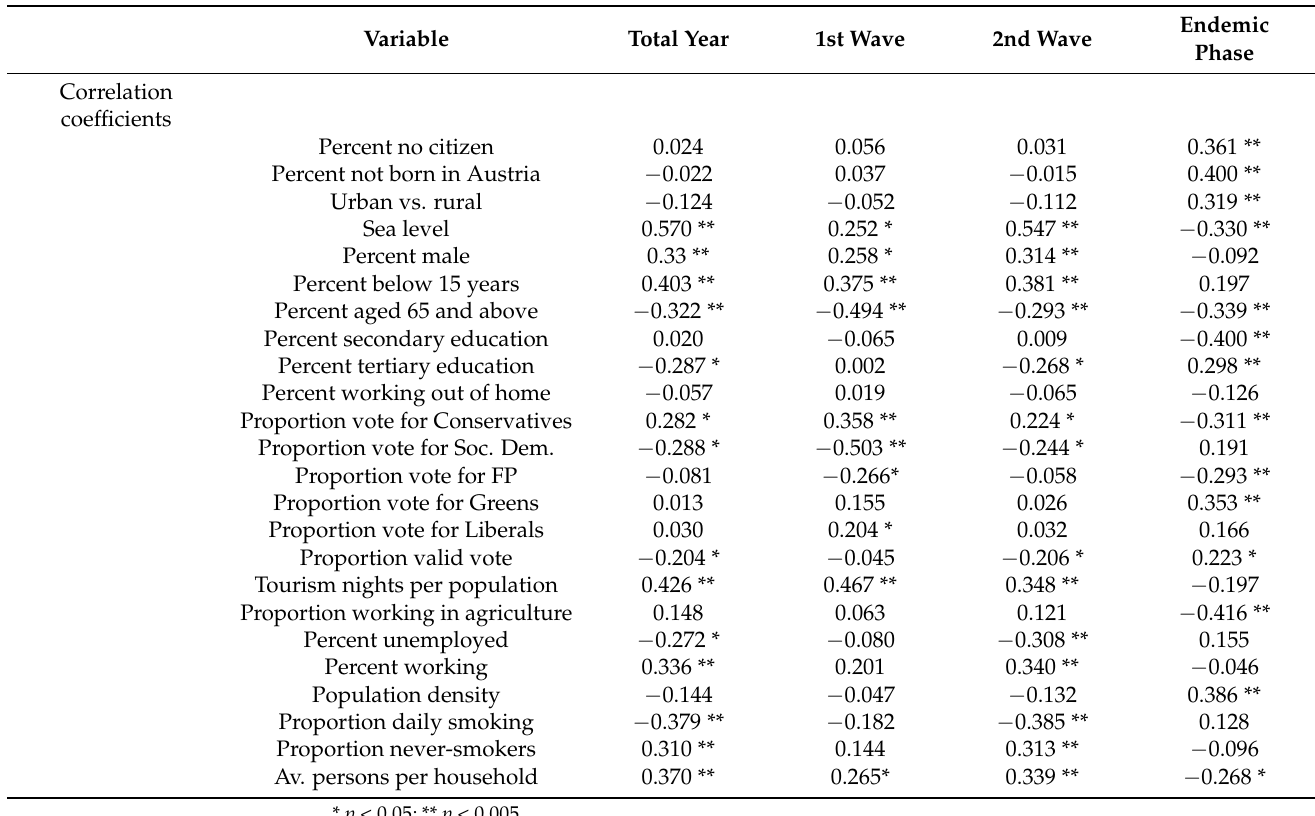
Table A1. Correlation coefficients between cumulative numbers and the independent variable ln (1 + cumulative number per 100,000).